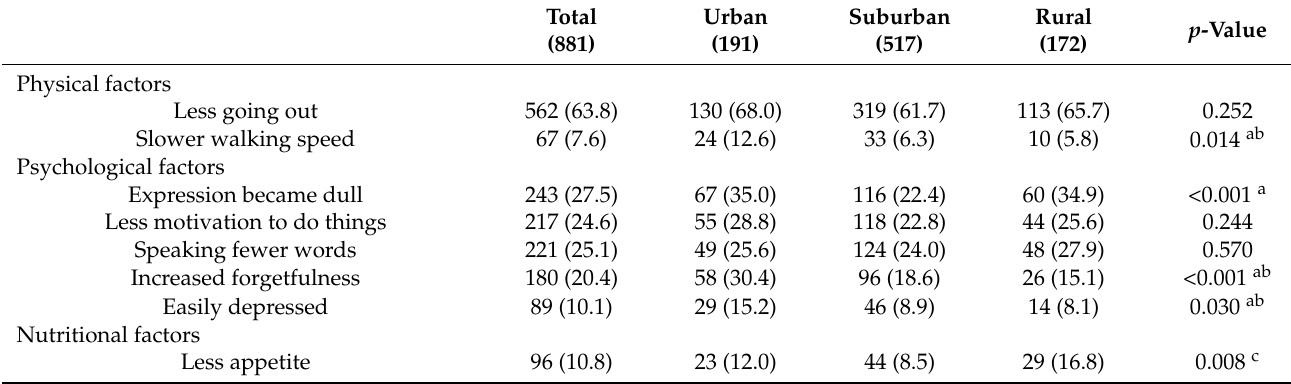
Table 2. Changes in resident behavior after the start of the pandemic (N, %) (Q4).